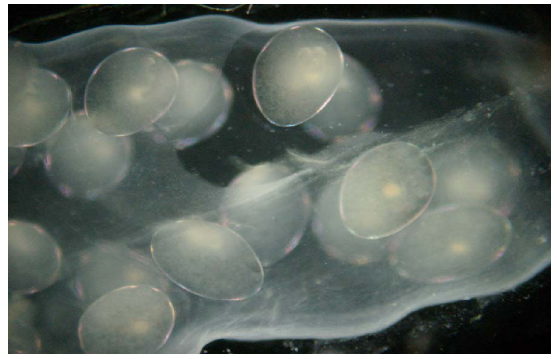
Figure 4. Embryos in eggs after 24 expositions in nitric acid solution, concentration = 228 mg ∙ dm 3 .